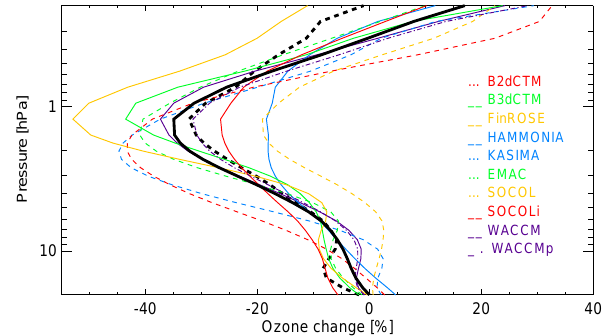
Fig. 29. Area-weighted averages (70–90 ◦ N) of observed and mod- eled relative O 3 changes with respect to 26 October during 16– 26 November . Thick solid and dashed lines represent model mean average and MIPAS observations, respectively. WACCMp denotes the WACCM simulation including proton ionization, only (excluded from the multi-model mean).